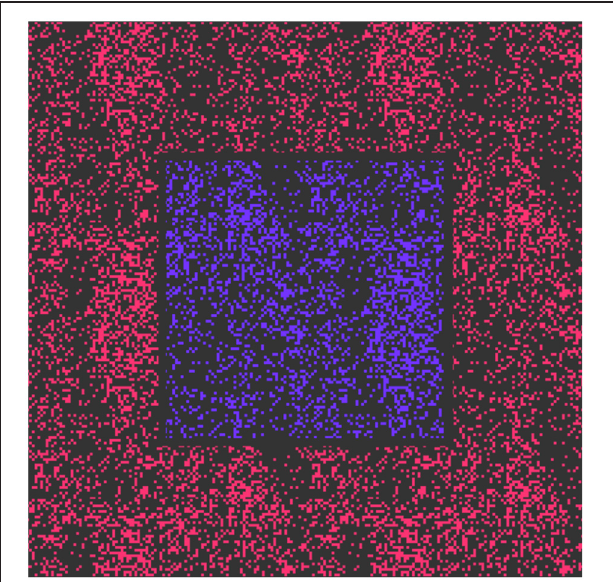
FIGURE 1 | Stimulus presented on a planar light-emitting diode (LED) display. The area of the central section is 300 × 300 pixel and the viewing area is 600 × 600